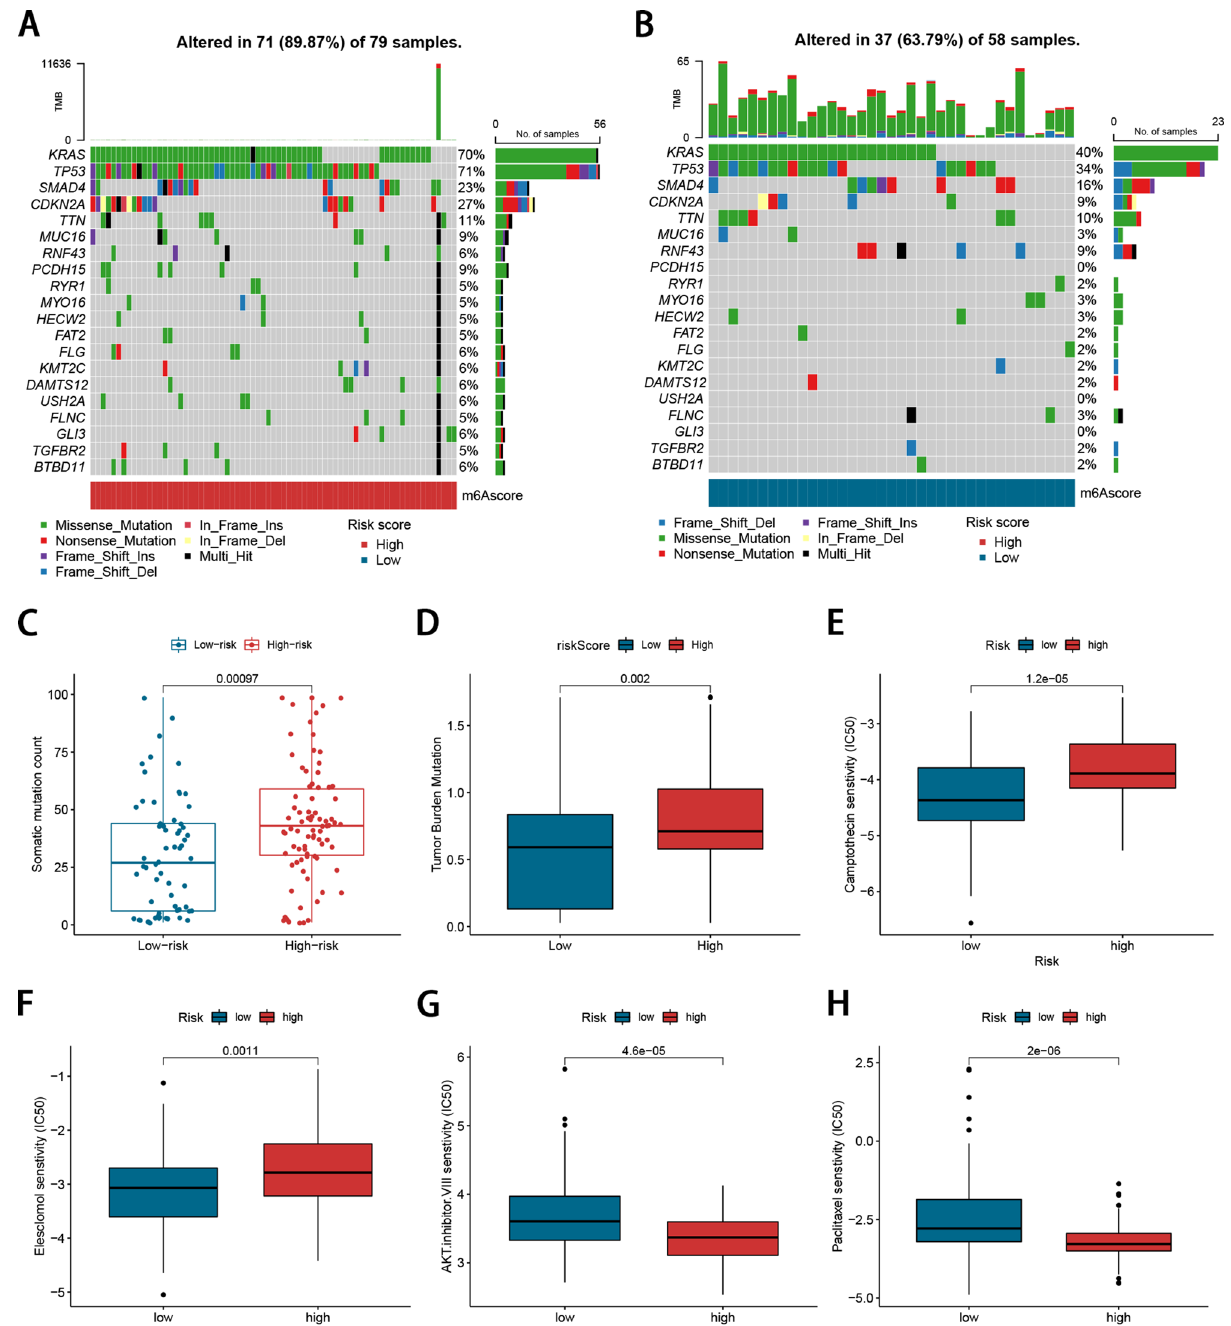
Figure 4. Comparison of the somatic mutations and drug sensitivity analyses between the two risk groups. ( A , B ) The waterfall plot of somatic mutation features established with the high-risk group and the low-risk group. Each column represented an individual patient. The upper barplot showed TMB, the number on the right indicated the mutation frequency in each gene. The right barplot showed the proportion of each variant type. ( C ) Correlation of somatic mutation count with risk score. ( D ) Correlation of TMB with risk score. ( E – H ) The IC50 values of four chemotherapeutic drugs in the high- and low-risk